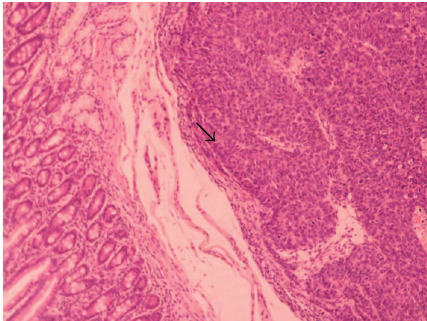
Figure 1: Adenocarcinoma of the pancreas.